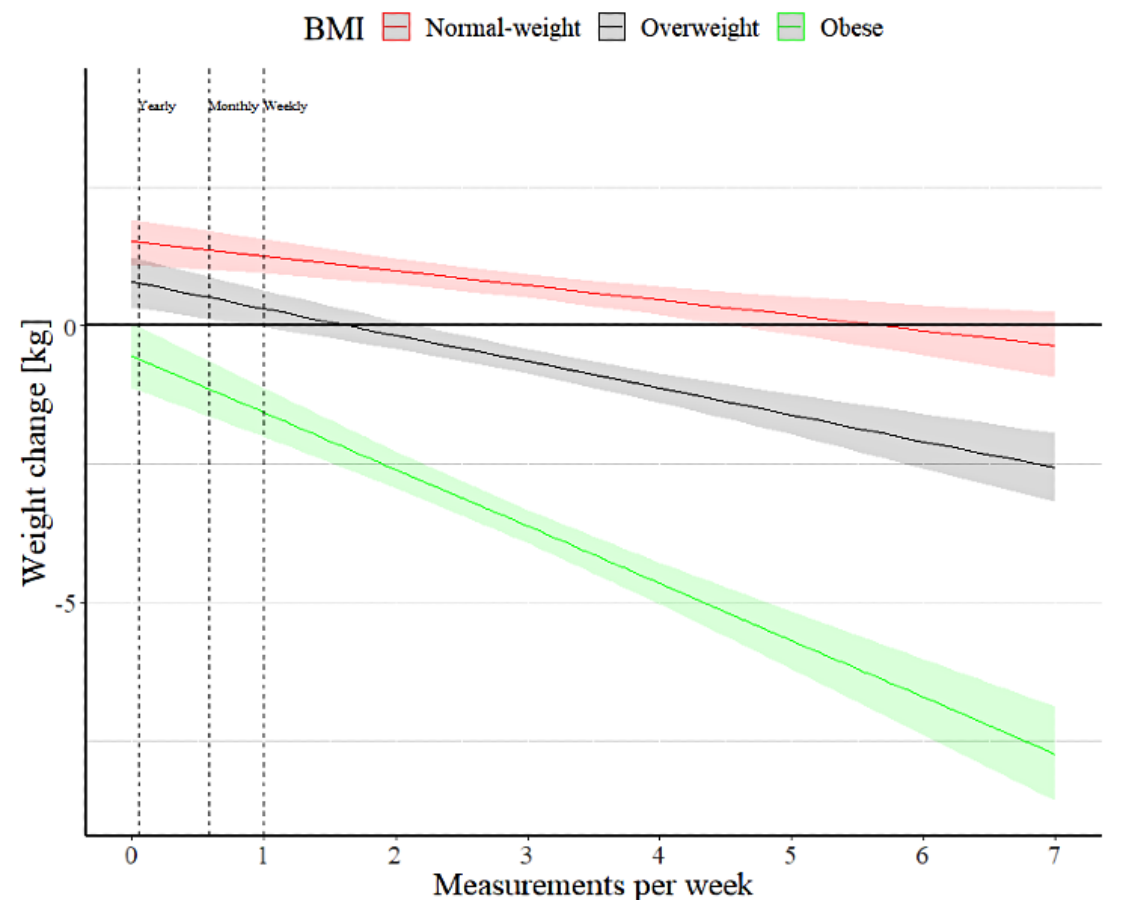
Figure 2. Weight change during the study follow-up predicted by the number of weight measurements per